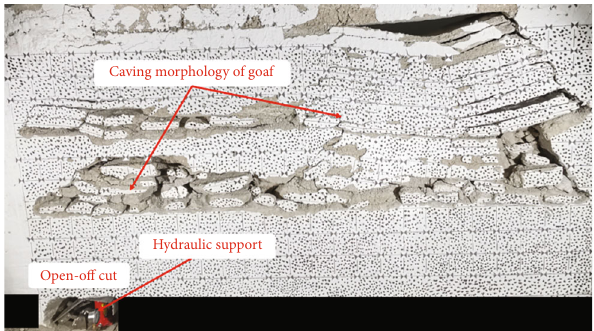
Figure 6: Open-o ff cut layout of working face.